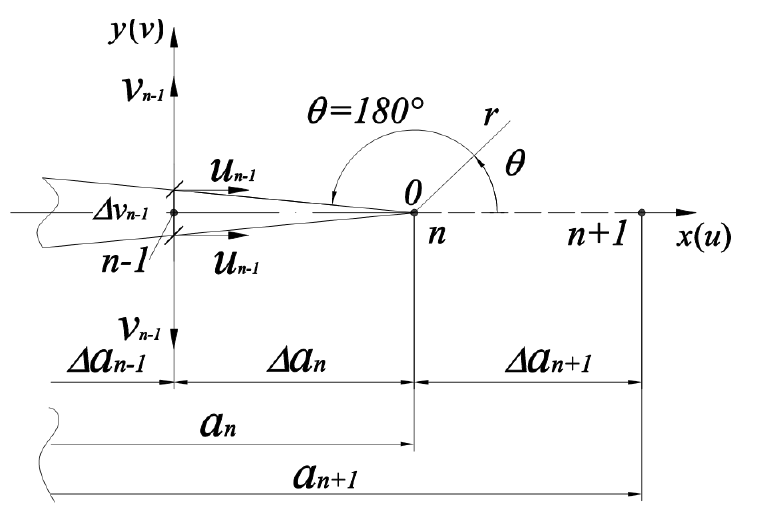
Figure 1: Polar co-ordinate system related to a crack tip and the notation adopted.